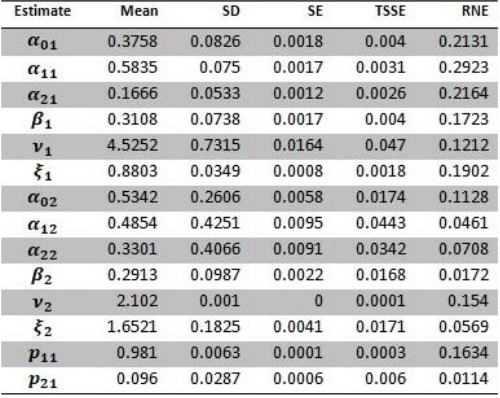
Table 9: Estimates of 2-State Regime E-GARCH with Skewed Student-t Innovations –